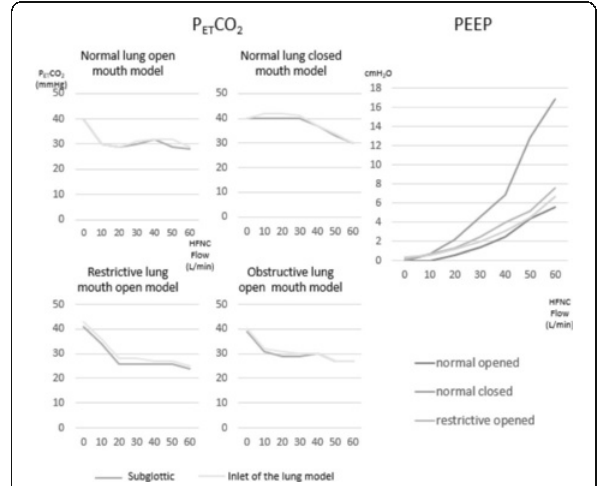
Fig. 137 (abstract A346). Relation of PETCO2, PEEP and HFNC